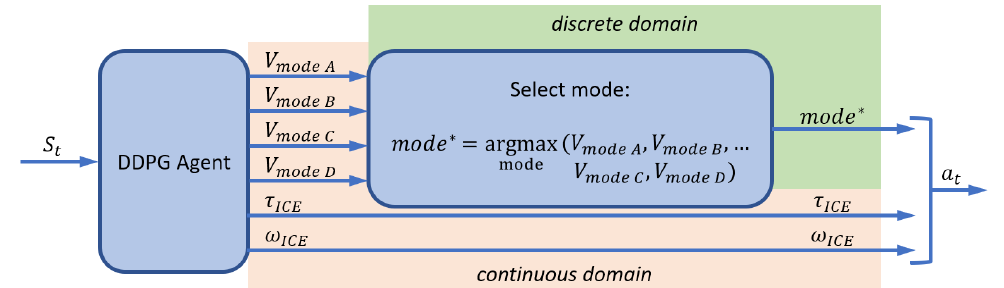
Figure 7. An illustration of the actor in the DDPG-based EMS used by Li et al. [64]. The DDPG agent uses six outputs to form three actions. Two of the actions are continuous, T e and ω e . The third action is the discrete selection of the operating mode with is found by performing an argmax command.